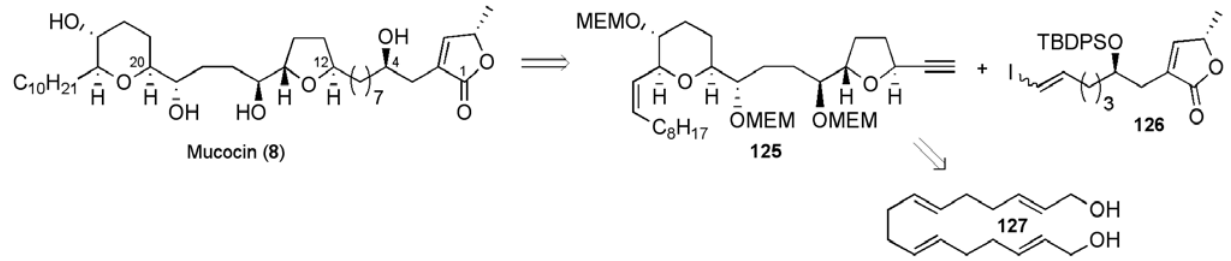
Figure 17. Sinha and Keinan’s route to mucocin ( 8 )